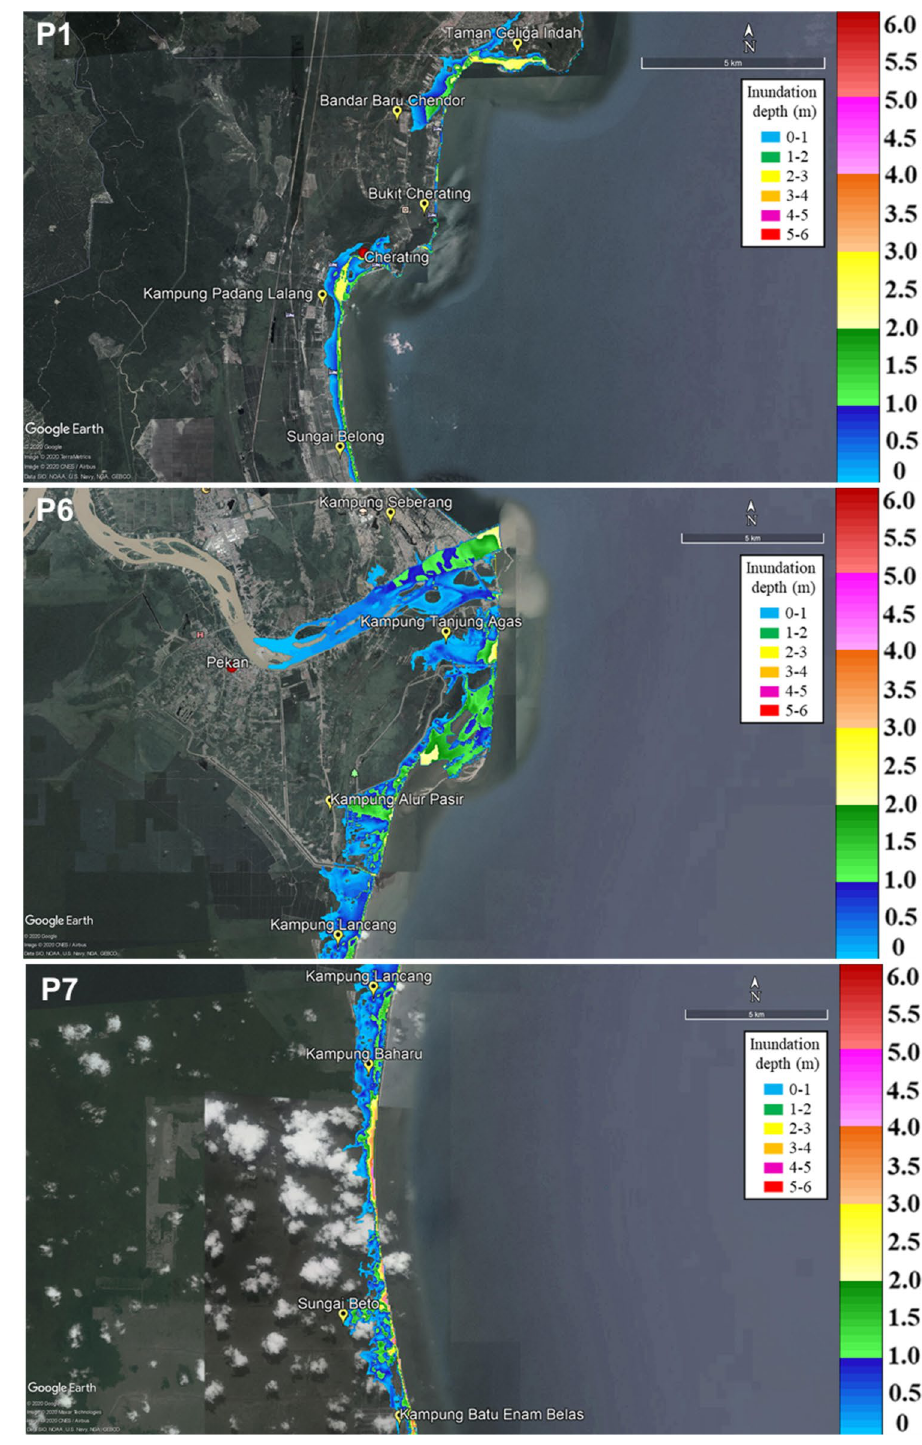
Fig. 10 Inundation map in Pahang at Mw